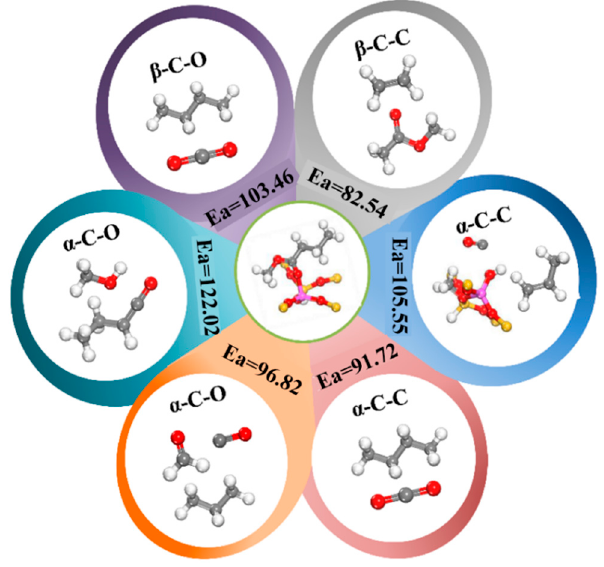
Figure 8. Summary diagram of the reaction path of methyl butyrate on the Lewis acid of ZSM-5 zeolite.